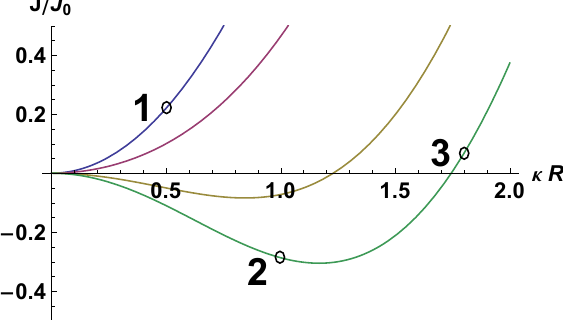
Figure 1. The total mass flow (20) vs. the dimensionless radius of the bridge. The parameter 8 ζ / ζ 0 = 1,5,10,12 from left to right. The numbered points represent the regions for which the velocity profile is given in Figure 3.